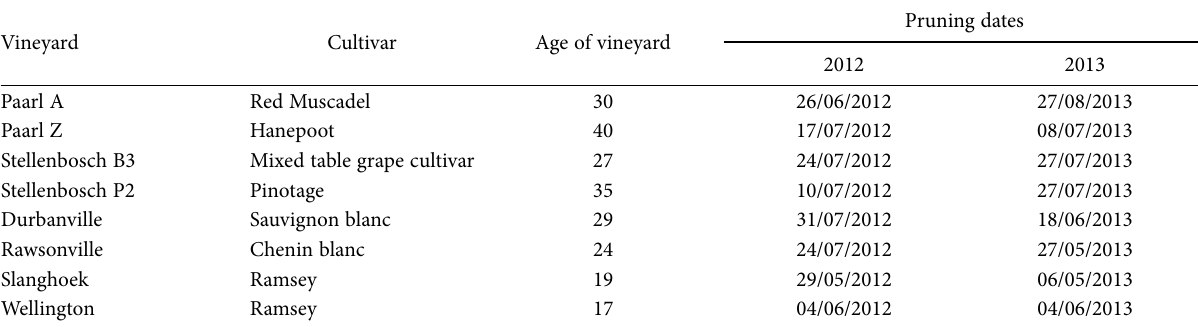
Table 1. Vineyards and rootstock mother vine nurseries in which spore trapping studies were conducted in 2012 and 2013.